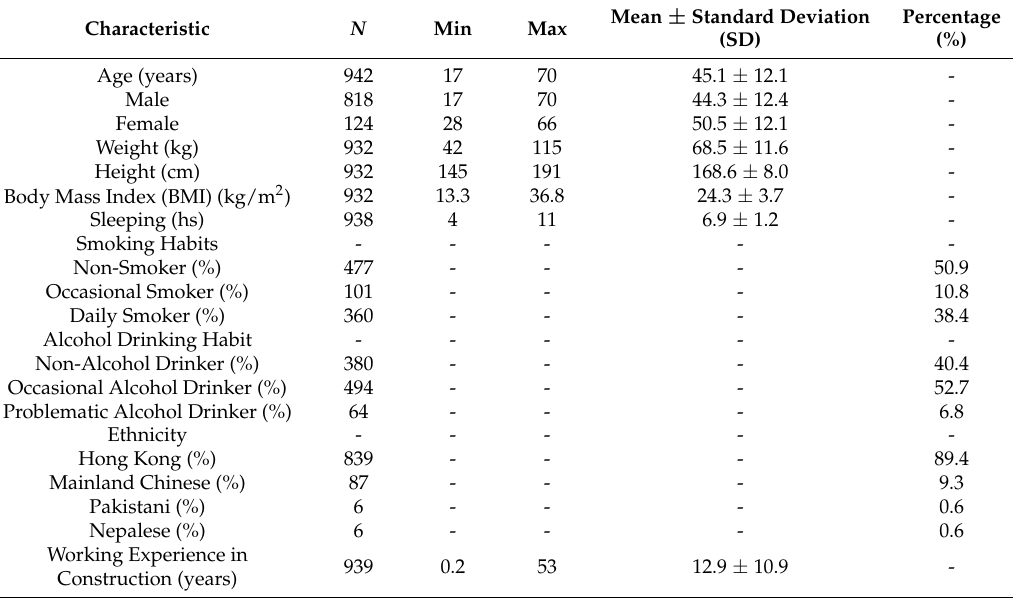
Table 1. Demographic details of participants of the PMES (sample size = 942).